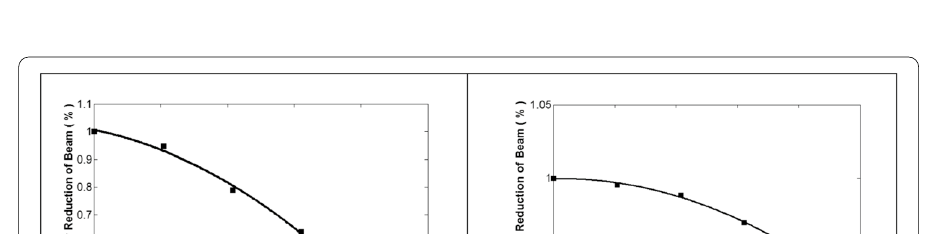
Fig. 9 Beam Deflection at various time intervals posteriori to the fire incident